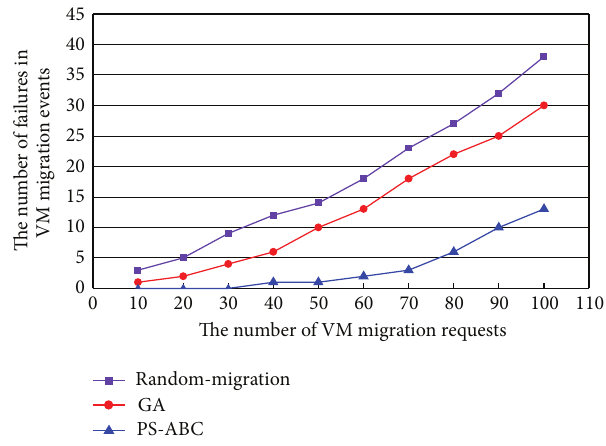
Figure 5: Comparison of the number of failures in VM migration events.